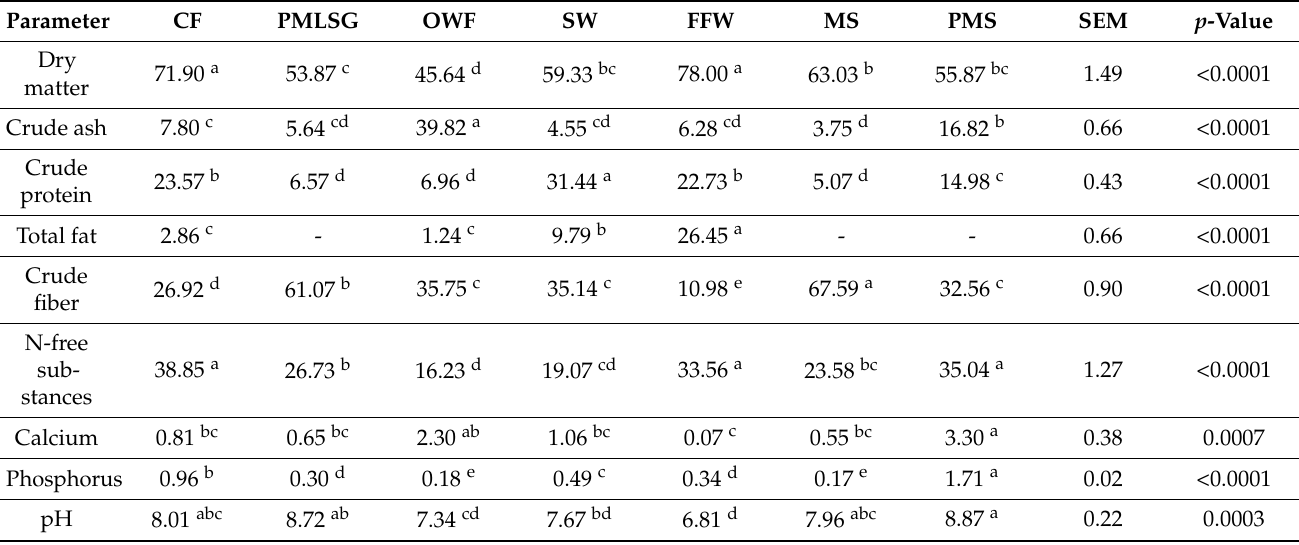
Table 4. Chemical composition of the frass by substrates 1 (dry matter expressed in %, all macronutri- ents expressed in % of dry